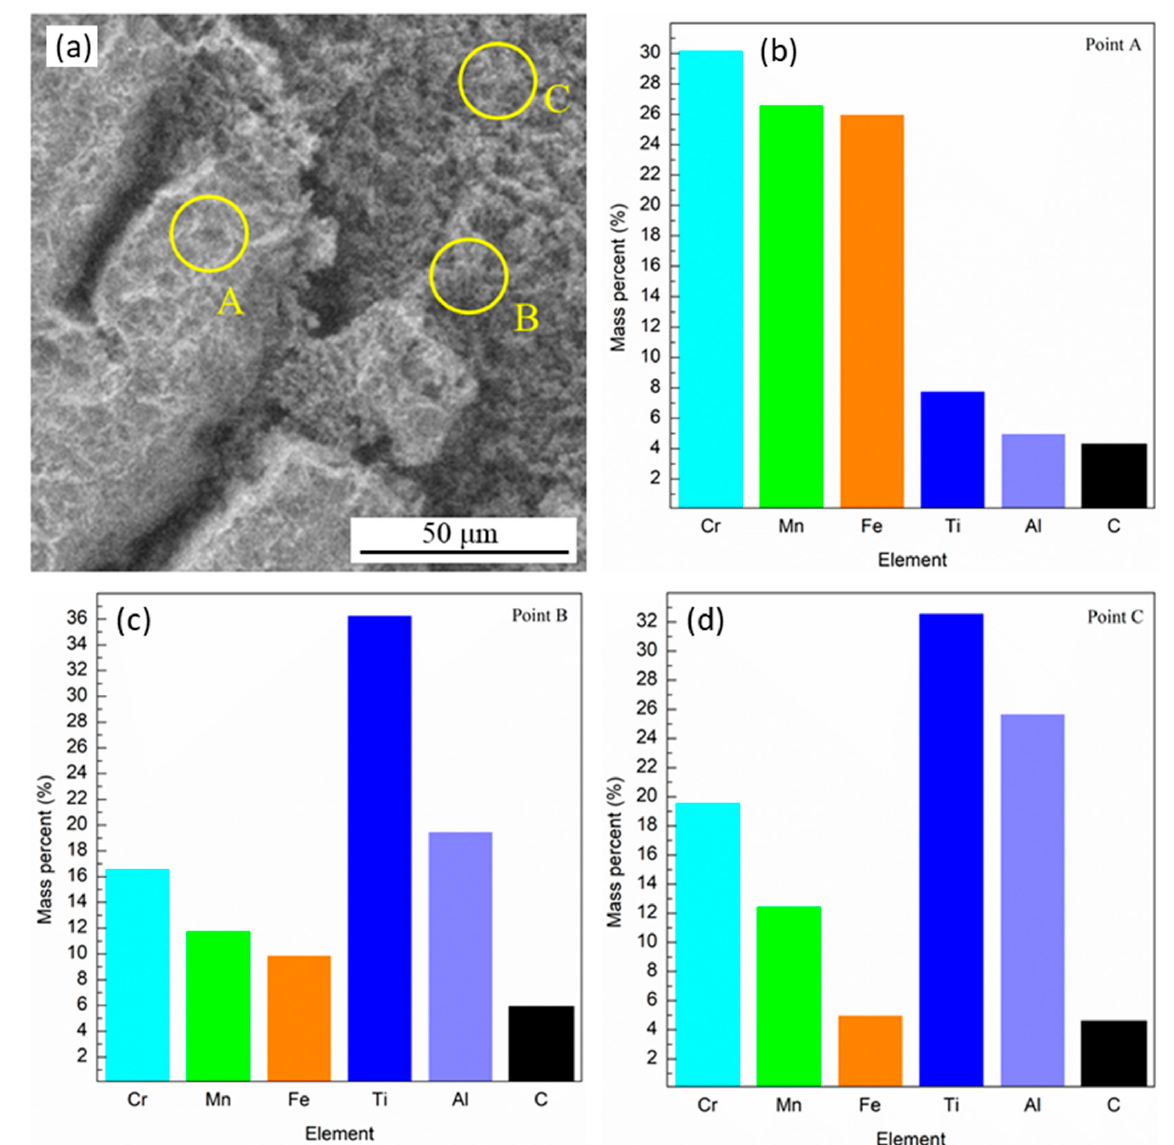
Figure 11. EDX analysis of Al 10 Cr 30 Fe 25 Mn 30 Ti 5 HEA in 2.5 M NaOH after the CPP: ( a ) SEM micrograph × 120, and EDX elemental composition of: ( b ) region A, ( c ) region B, and ( d ) region C.